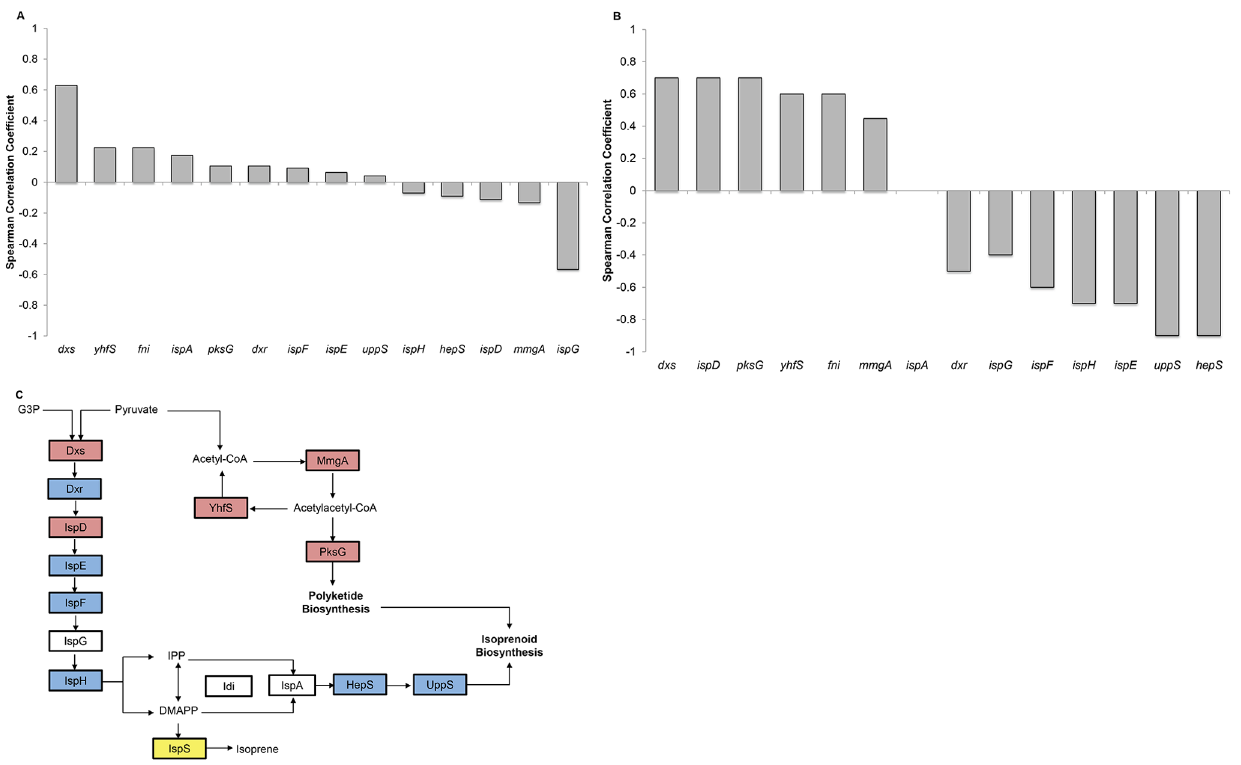
Figure 5. dxs gene expression has the strongest correlation with isoprene production. A, Spearman’s correlation coefficients were calculated between gene expression and isoprene production using all 12 perturbations; wild type control, acetic acid, ethanol, lactic acid, indole, 0.005% H 2 O 2 , 0.02% H 2 O 2 , OX- dxs , OX- fni , DMSO, empty vector, and OX- ispA . Refer to Figure 2A for gene names. B, Spearman’s correlation coefficients were calculated for the subset of five perturbations: wild type control, acetic acid, ethanol, lactic acid, and indole. Refer to Figure 2A for gene names. C, Genes that positively correlate with isoprene are shown in red, genes that inversely correlate with isoprene are shown in blue, genes with little correlation are not shaded, and genes with an unknown relationship are shown in